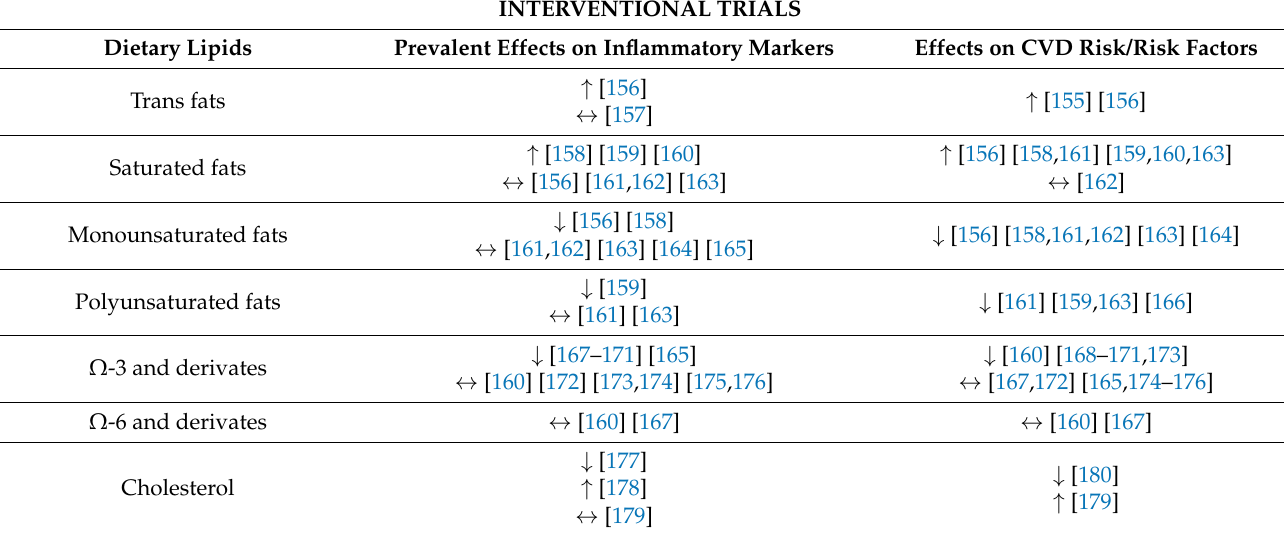
Table 2. Summary of data from interventional studies about the association between dietary intake of lipids, circulating markers of systemic inflammation and risk of cardiovascular diseases. ↑ : Indicates data showing a positive association between the dietary intervention and the outcome (either inflammatory markers or CVD risk factors); ↓ indicates data showing a positive association between the dietary intervention and the outcome (either inflammatory markers or CVD risk factors). ↔ indicates that there are missing or contrasting data regarding association between the dietary intervention and the outcome (either inflammatory markers or CVD risk